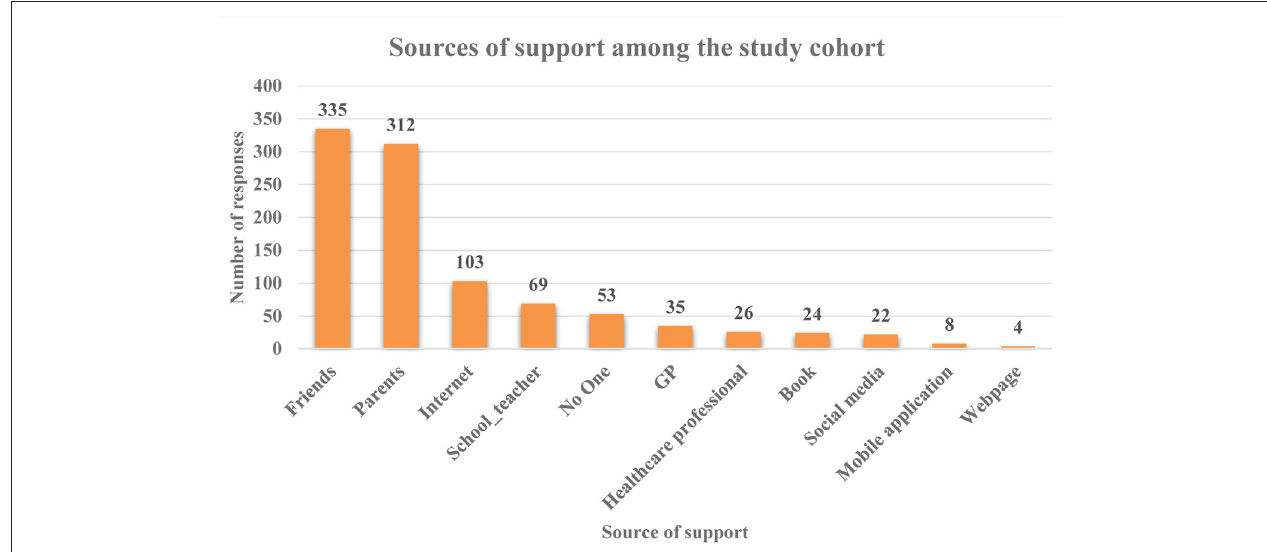
FIGURE 2 | Sources of support among the study cohort. Number of responses, n = 991.